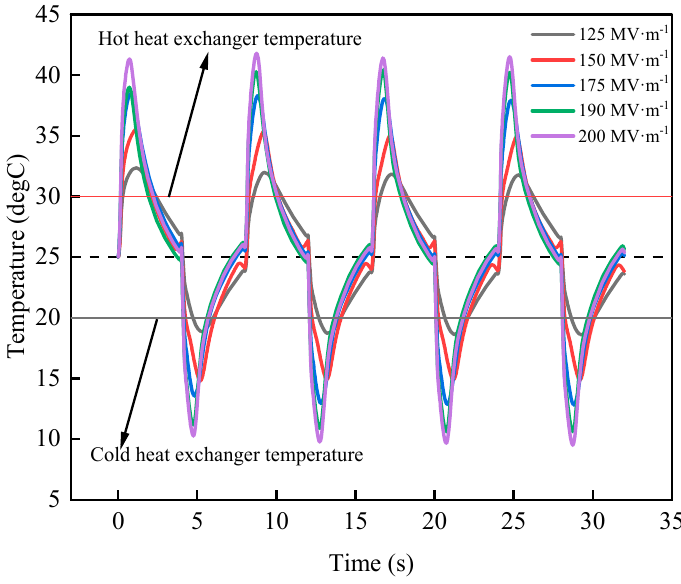
Figure 16. Temperature change of EC material under different electric field intensities. As exhibited in Figure 16, a higher electric field can induce larger ECE so that the temperature change of the EC material becomes more intense. Consequently, the values of Q h and Q c will be larger because the fluid exchanges more heat with the EC material, which is consistent with the variation trend of Q h and Q c depicted in Figure 17. However, COP fluctuates with the increase in electric field intensity and reaches the maximum when the electric field intensity is 150 MV · m − 1 .